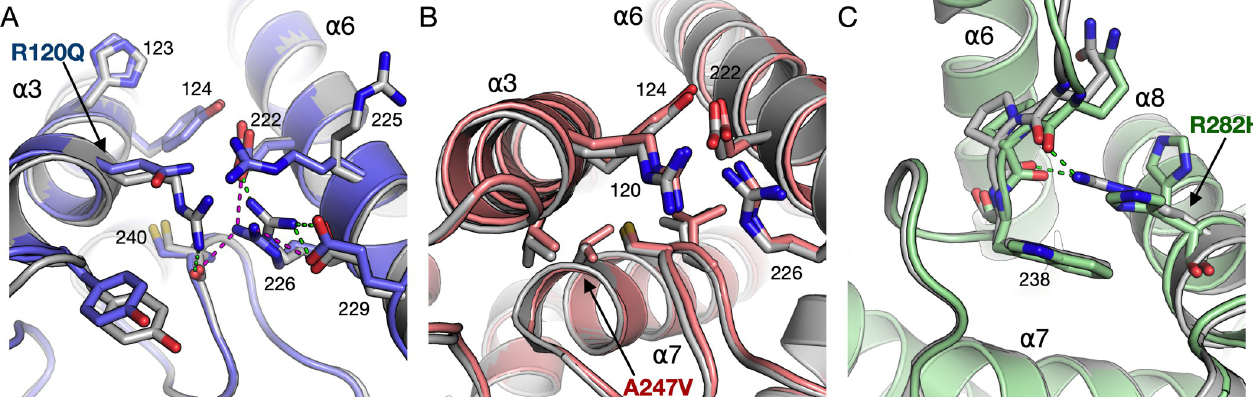
Fig 2. Structural details for each point mutation studied by X-ray crystallography in this study. A. Immediate environment of the R120Q mutation. Arg120 participates in a hydrogen bond network between helices α 3 and α 6. B. Effects of the A247V mutation. Ala247 on helix α 7 is a central residue of the GDAP1 hydrophobic core. C. The R282H mutation. Arg282 interacts with the α 6- α 7 loop, and the mutation causes loss of these interactions. The structure of wild-type GDAP1 is shown in grey in all panels.